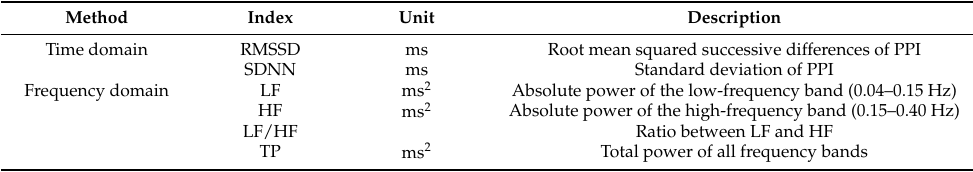
Table 1. Heart rate variability indices used in this